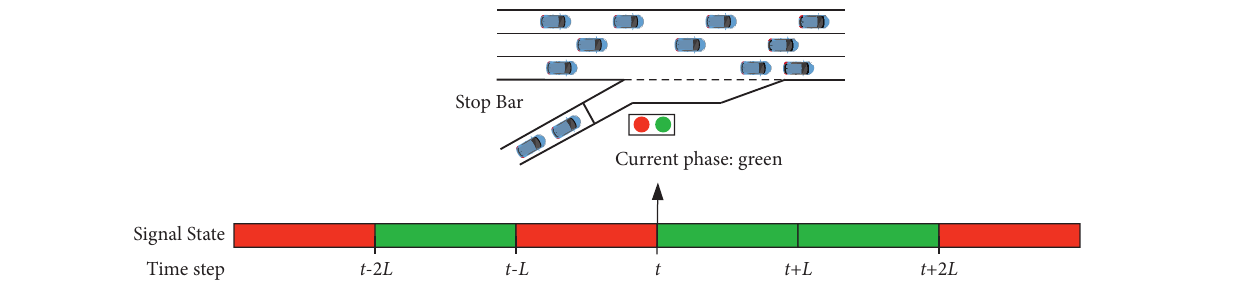
Figure 1: Two-phase control scheme for ramp metering.